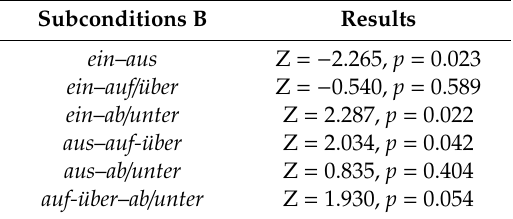
Table 3. Results of a series of Wilcoxon tests concerning Subconditions B in the interpretation posttest.